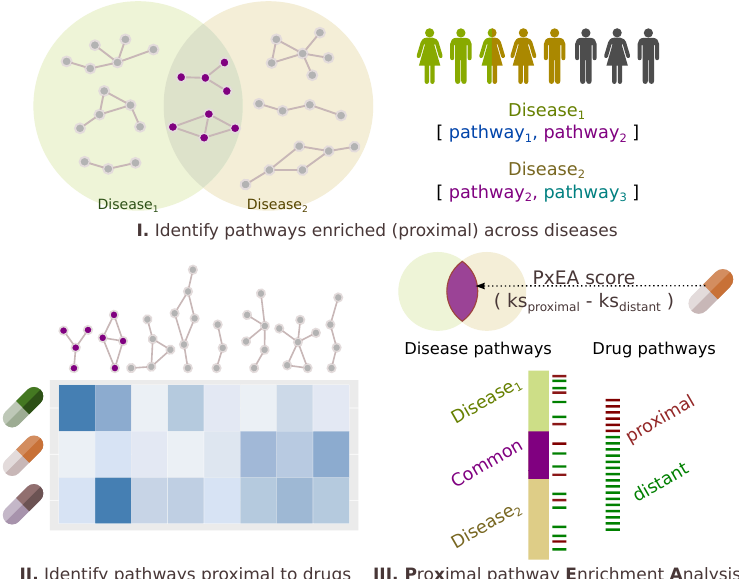
Figure 3. Schematic overview of proximal pathway enrichment analysis (PxEA). PxEA scores a drug with respect to its potential to target the pathways shared between two diseases. For a given drug and two diseases of interest, PxEA first identifies the common pathways between the two diseases and then uses the proximity-based ranking of the pathways (i.e., average distance in the interactome to the nearest pathway gene, normalized with respect to a background distribution of expected scores) to assign a score to the drug and the disease pair.